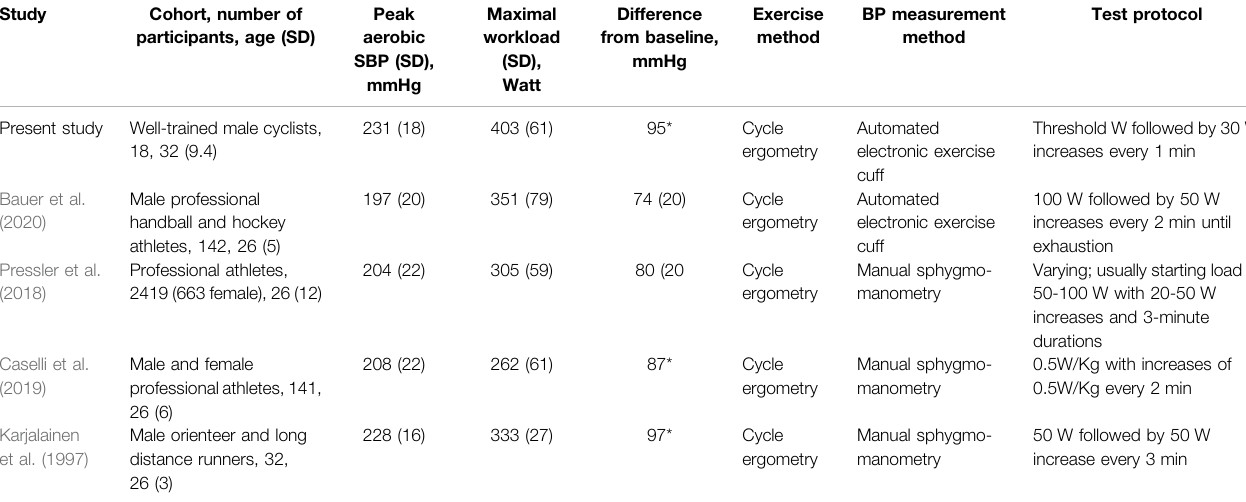
TABLE 3 | Overview of similar